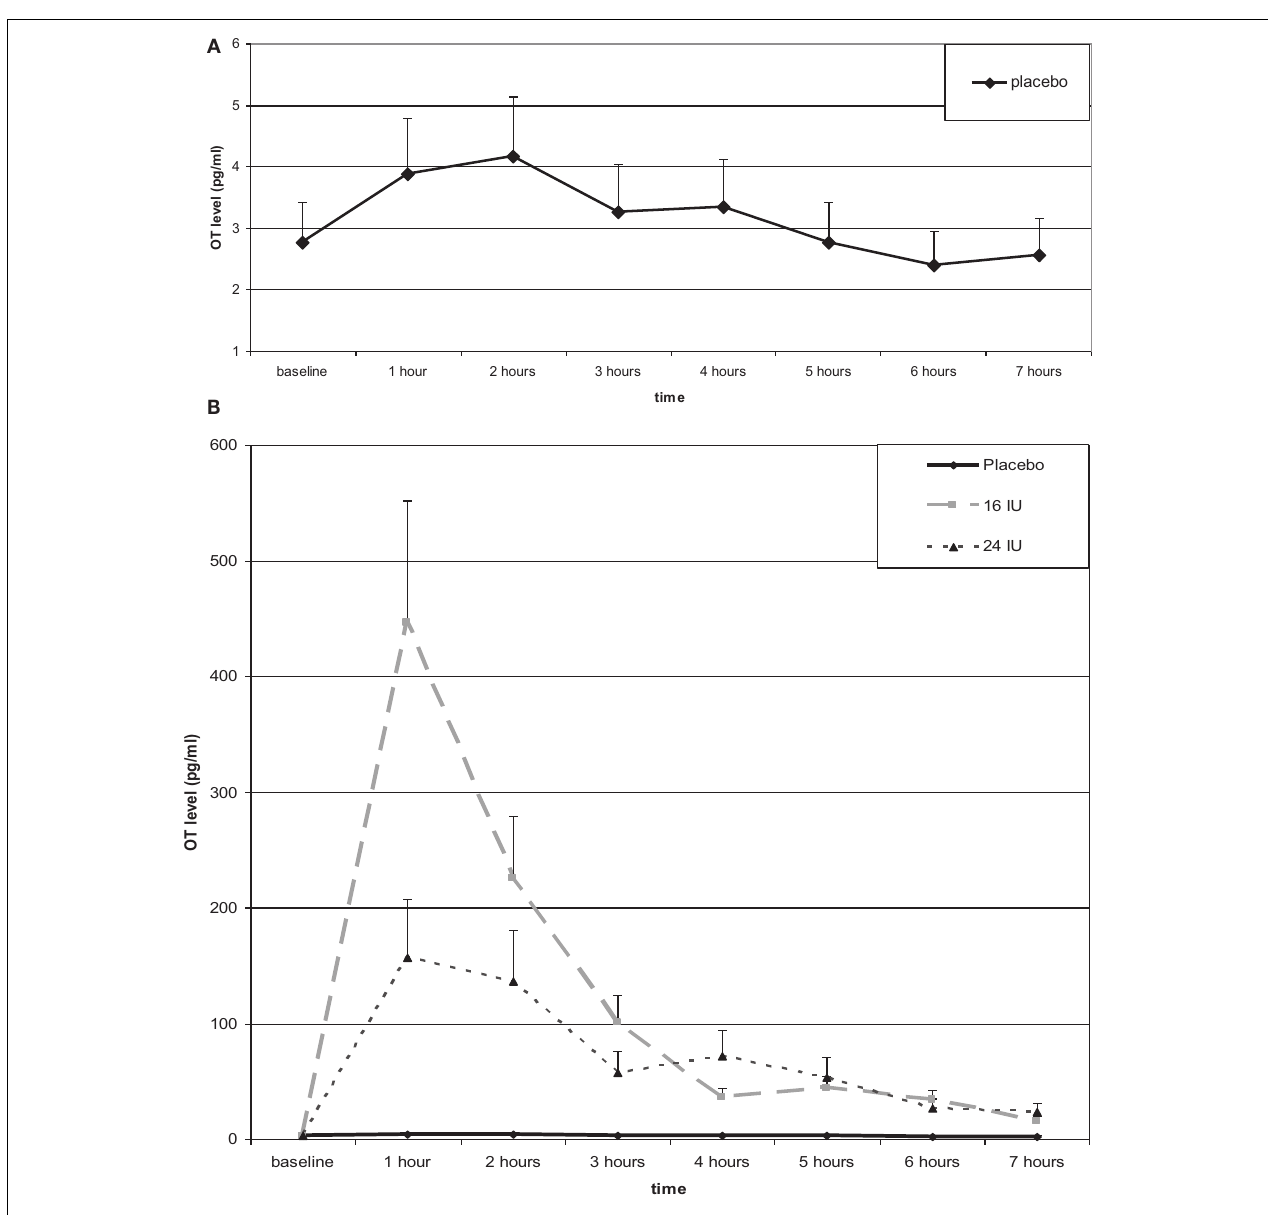
FIGURE 1 | Salivary oxytocin levels over the day in placebo (A,B) and afterAdministration of 16 or 24 IU oxytocin (B). Oxytocin or placebo was administered through nasal spray directly after the baseline assessment; subsequent assessments every hour after administration of oxytocin or